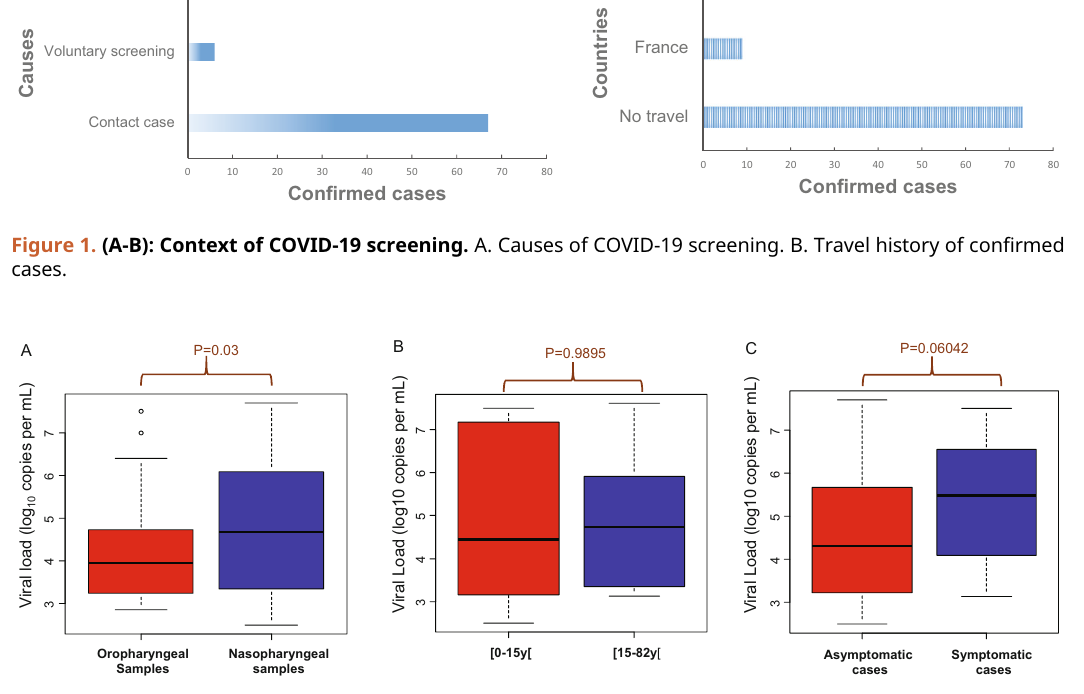
Figure 2. (A-C): Viral load of SARS-CoV-2 in clinical samples. A: Viral load from oropharyngeal and nasopharyngeal samples. B: Comparison of viral loads in two age groups. C: Comparison of viral loads in symptomatic and asymptomatic people.